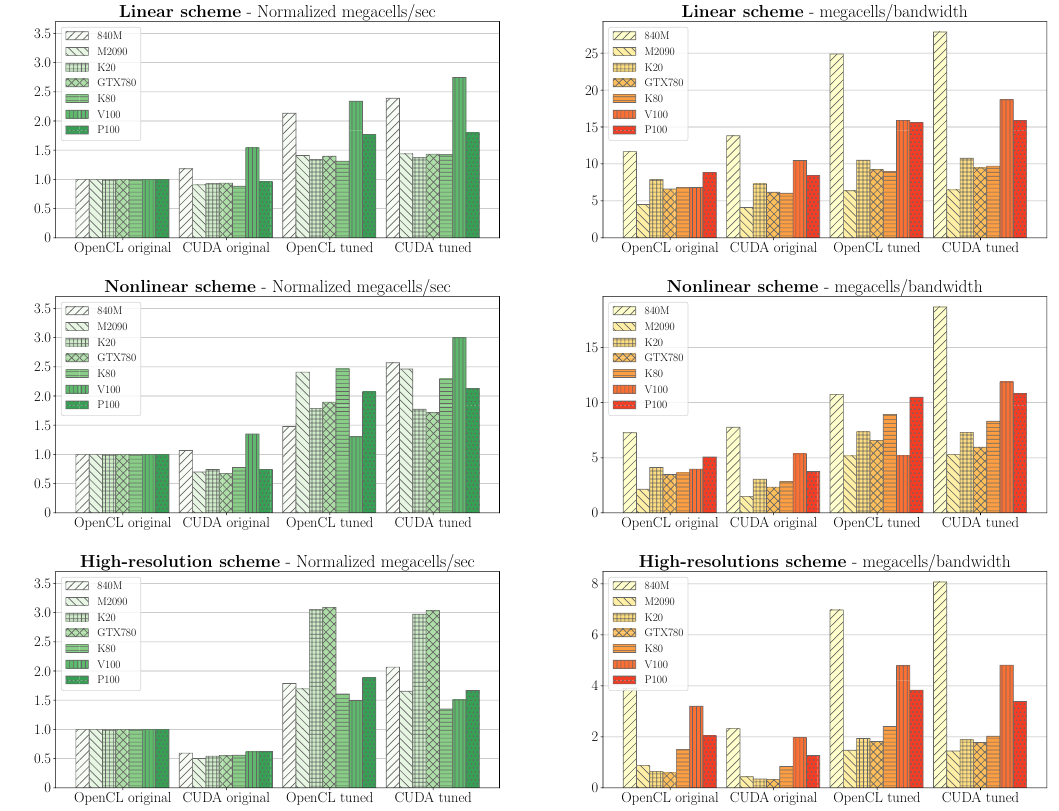
Figure 6. Performance of original, ported, and optimized kernels measured in megacells per second. The left column is normalized with respect to original performance, and the right column with respect to the theoretical GPU bandwidth. Notice that there is relatively little difference between CUDA and OpenCL, whilst there is a significant difference in how effective the tuning is for the different architectures. Furthermore, there is a significant loss of performance when porting from OpenCL to CUDA in our original approach for the high-resolution and nonlinear schemes. From our experience, this relates to how the two languages optimize mathematical expressions with and without the fast math compilation flags. Also notice that the 840M, V100, and P100 GPUs achieved the best performance relative to the GPU